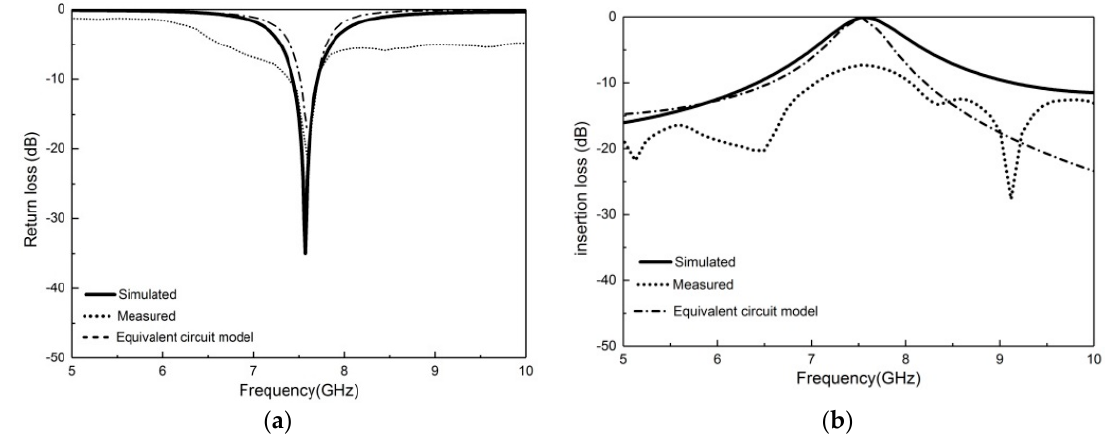
Figure 4. ( a ) Return loss ( b ) Insertion loss responses of the electromagnetically simulated, measured and equivalent circuit model of the bandpass filter.